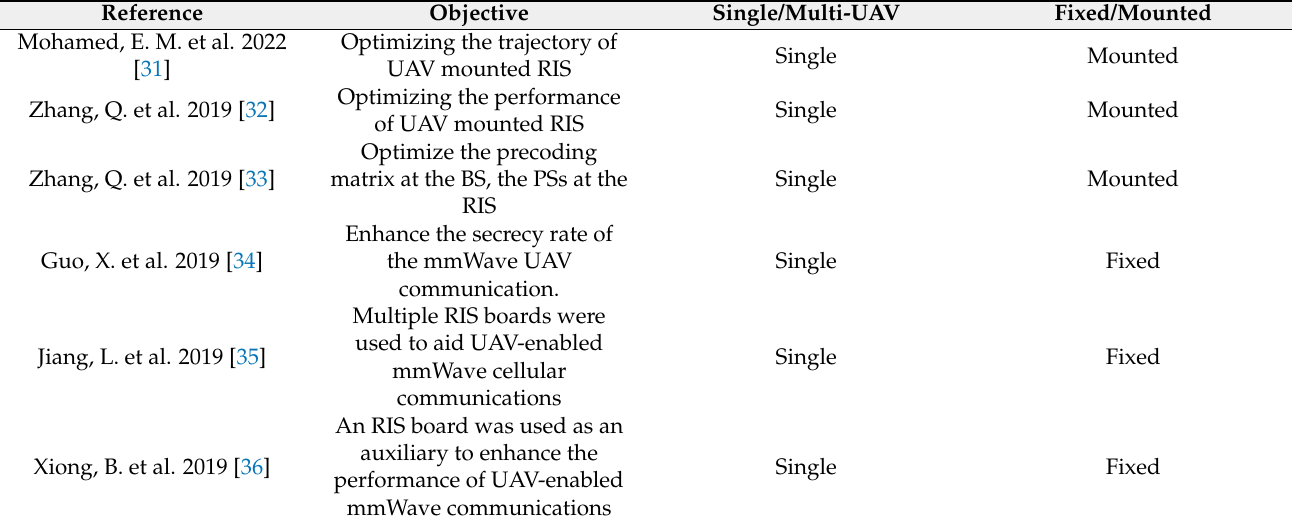
Table 1. Literature review comparison in RIS assisted mmWave UAV